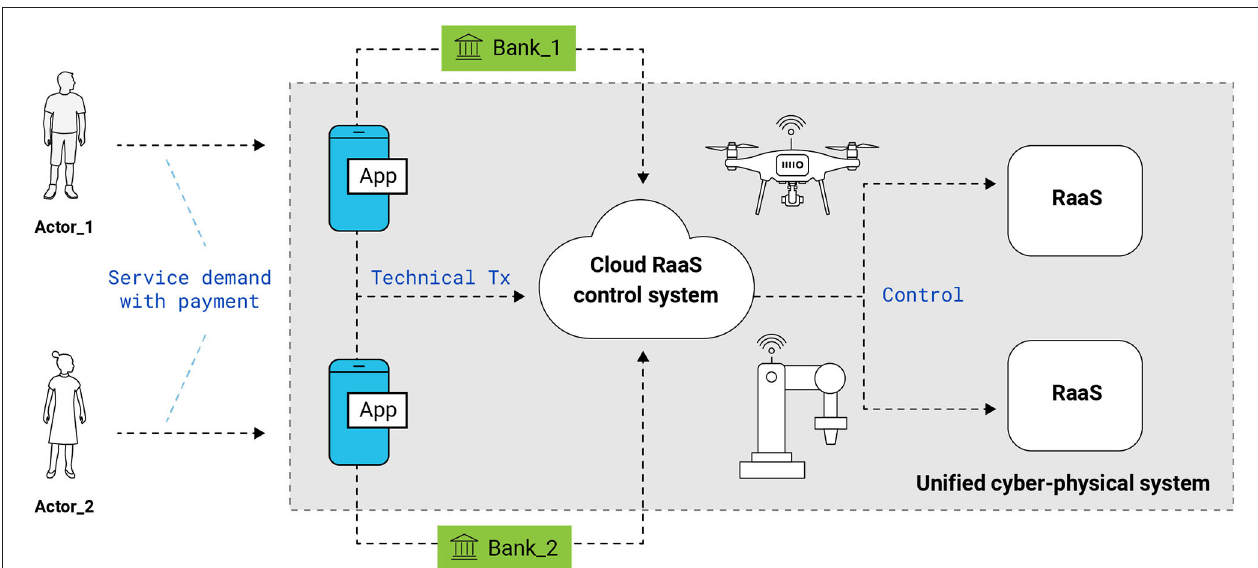
FIGURE 1 | An example scheme of the RaaS architecture is based on cloud solutions. Actors (i.e., users) send a request for the provision of a service through the application. The request is then divided into an economic transaction (which is processed in a standard way through the banking system) and a technical transaction sent to the cloud. The cloud then sends command signals to the needed